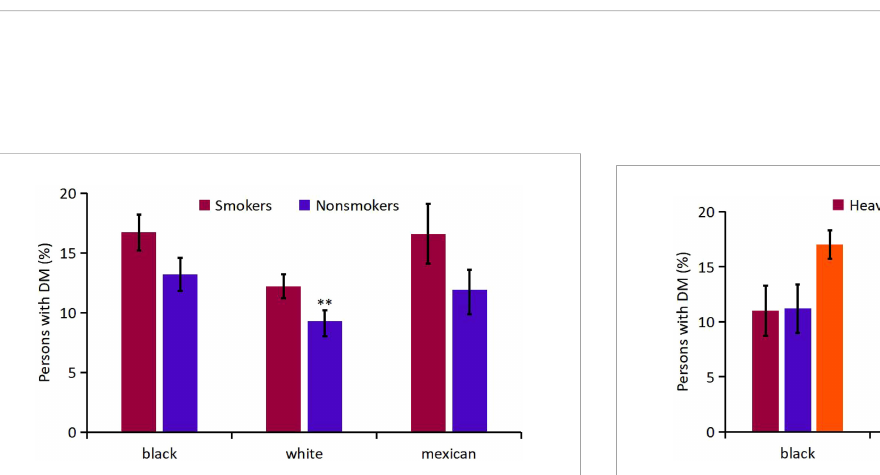
FIGURE 7 Analysis on the Mean percentage of participants with DM in alcohol- drinking groups of different